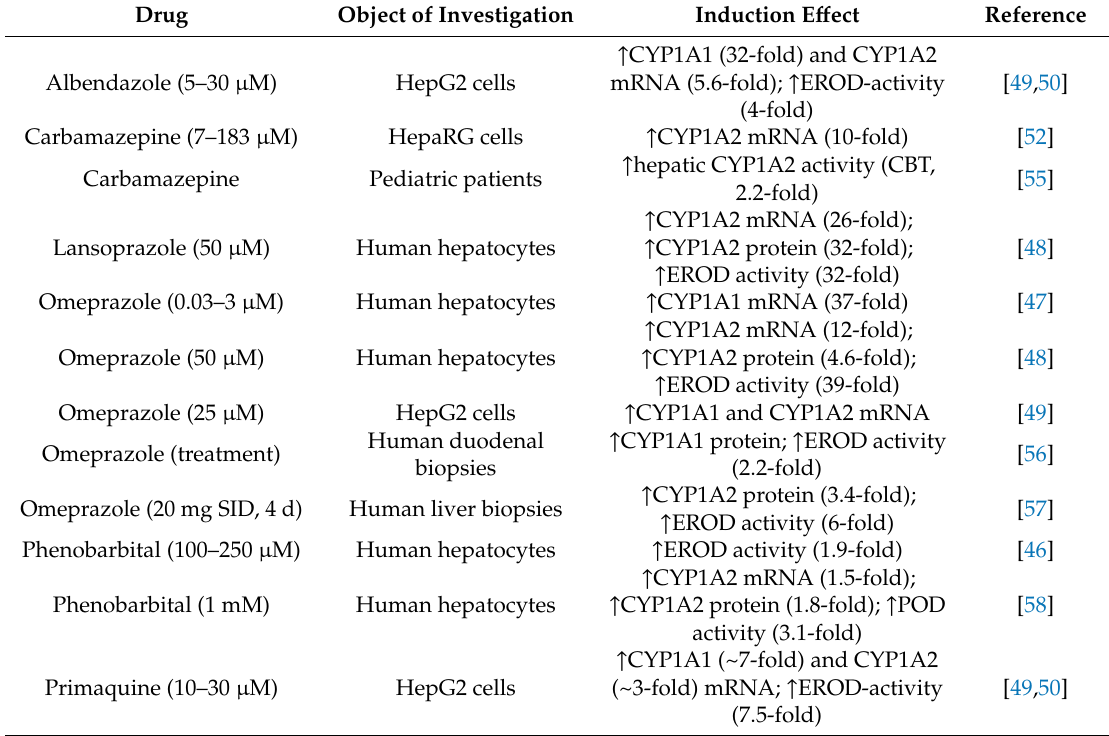
Table 2. Impact of clinically relevant drugs, smoking, and diet on the induction of CYP1A1 / 1A2 mRNA, protein, and